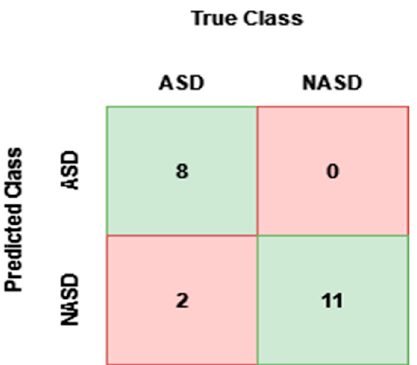
Figure 10. Confusion matrix of combined handwritten task classification.